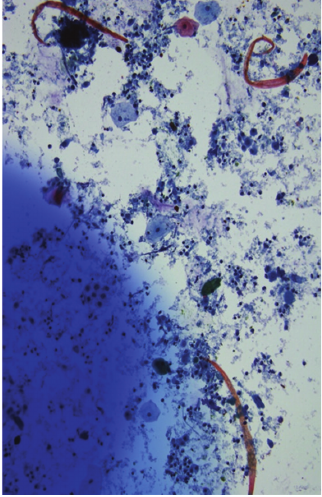
Figure 3: Washings from parisitoma revealing larval